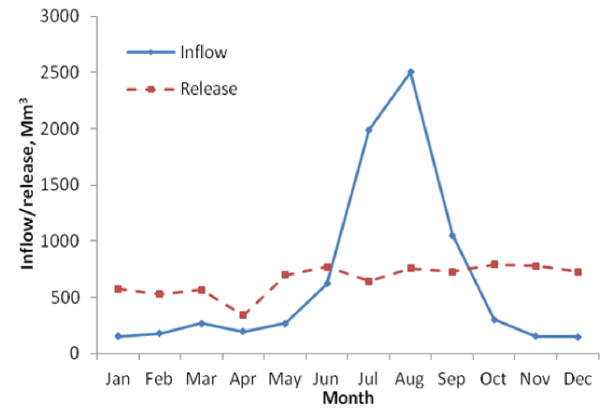
Figure 4. Average monthly inflow and irrigation demands from the Pong reservoir (data: